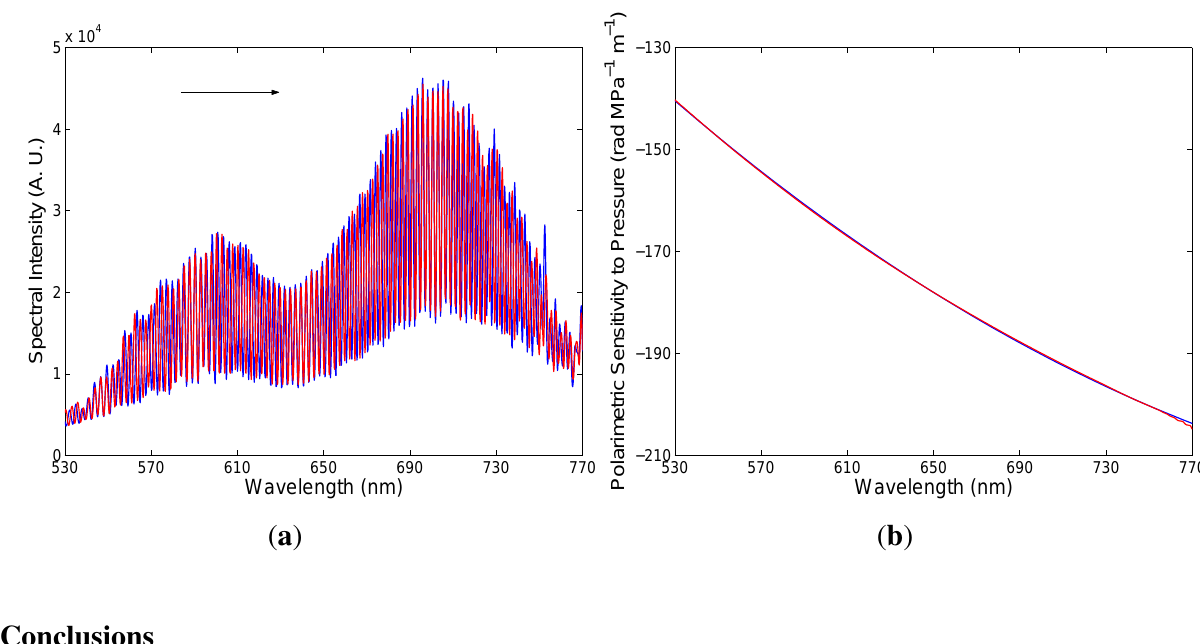
Two recorded spectra corresponding to the second delay and hydrostatic = 0 . 3 MPa (blue) and p = 0 . 99 MPa (red) ( a ). The spectral dependence pressures, p 1 2 of the polarimetric sensitivity to hydrostatic pressure ( b ). The red line is the approximate quadratic